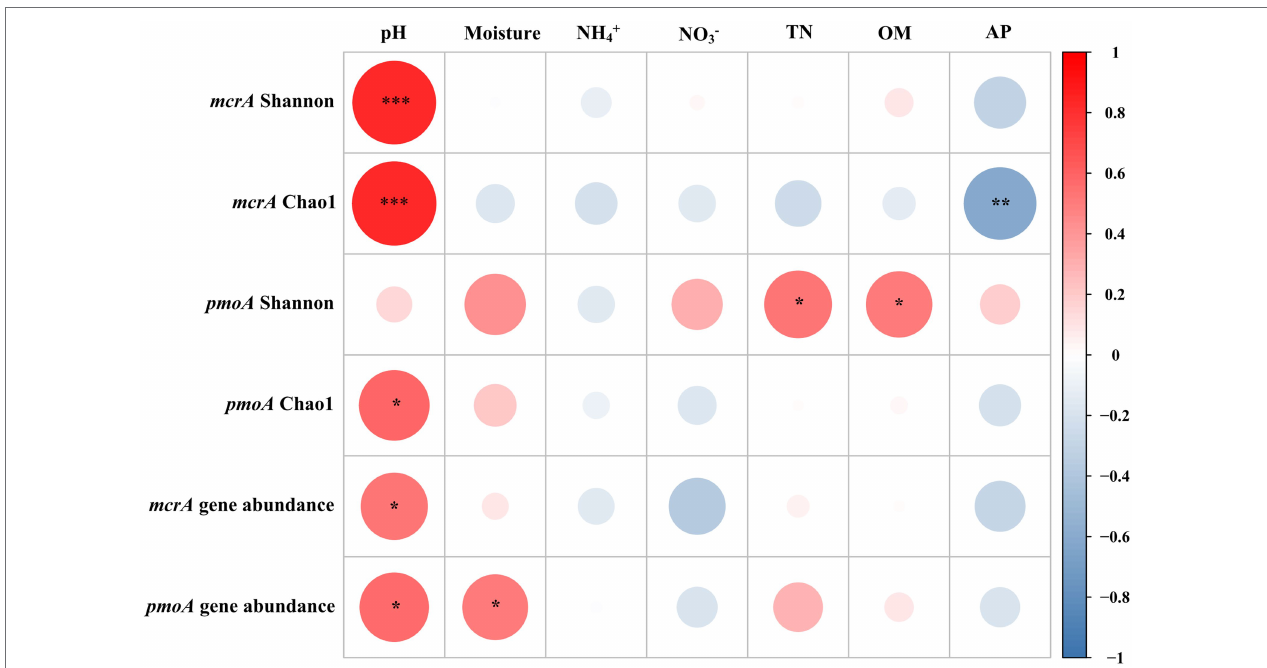
FIGURE 3 | Correlation analyses of diversity indices and abundances of methanogens ( mcrA ) and methanotrophs ( pmoA ), and mcrA and pmoA gene abundances with soil properties. Asterisks represent statistically significant relationships (*** p < 0.001, ** p < 0.01, and * p < 0.05). The color code depicted the r-value of Spearman